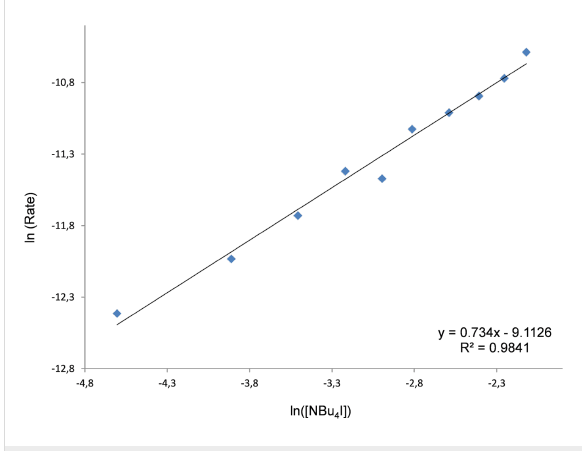
Figure 3: Double logarithmic plot and to determinate the order in NBu 4 I. Conditions: 1,2-epoxyhexane (10 mmol) as substrate, 50 °C, 1.0 MPa of CO 2 , 18 h, [NBu 4 I] = 0.01–0.12 mol %.